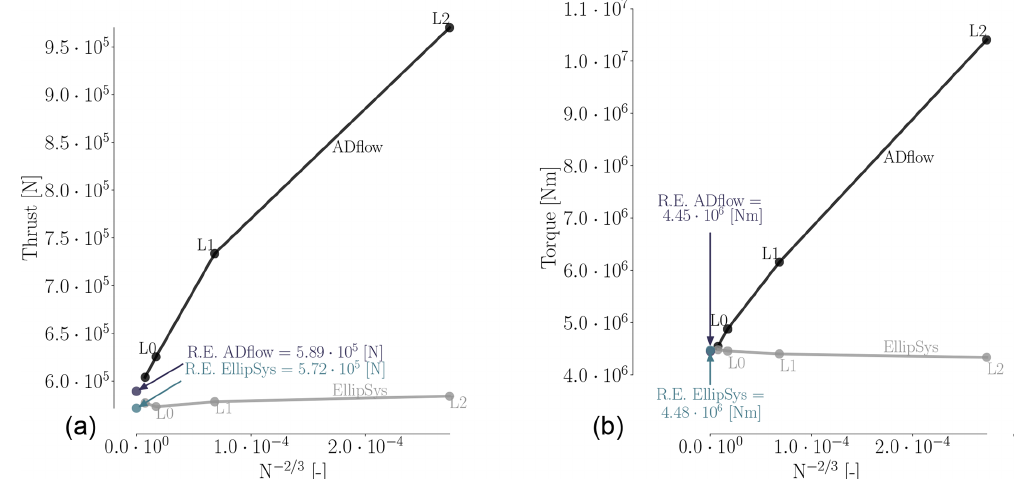
Figure 5. Richardson extrapolation (Eq. 7) for the grid convergence study for thrust (a) and torque (b) . Between the two solvers, the extrapolated continuum values for thrust differ by 3%, whereas the errors for the torque values vary by less than 0.7%. Table 4. Mesh convergence study for the compressible solver ADflow and the incompressible solver EllipSys3D. The operational conditions for the convergence study correspond to the 8ms − 1 case listed in Table A1. The error percentages are estimated using the Richardson extrapolations from Fig. 5. ADflow